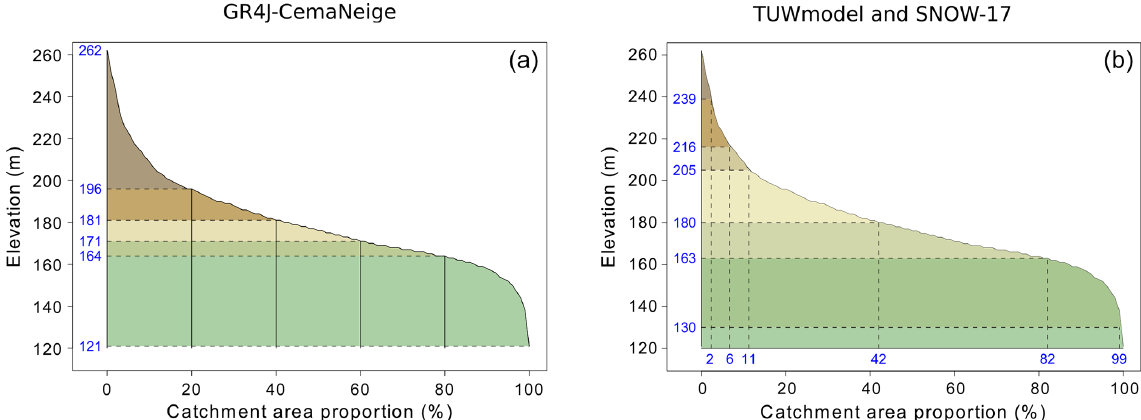
Figure 2. Example of GR4J-CemaNeige elevation zones (a) and TUWmodel/SNOW-17 elevation zones (b) , with both following the hypso-